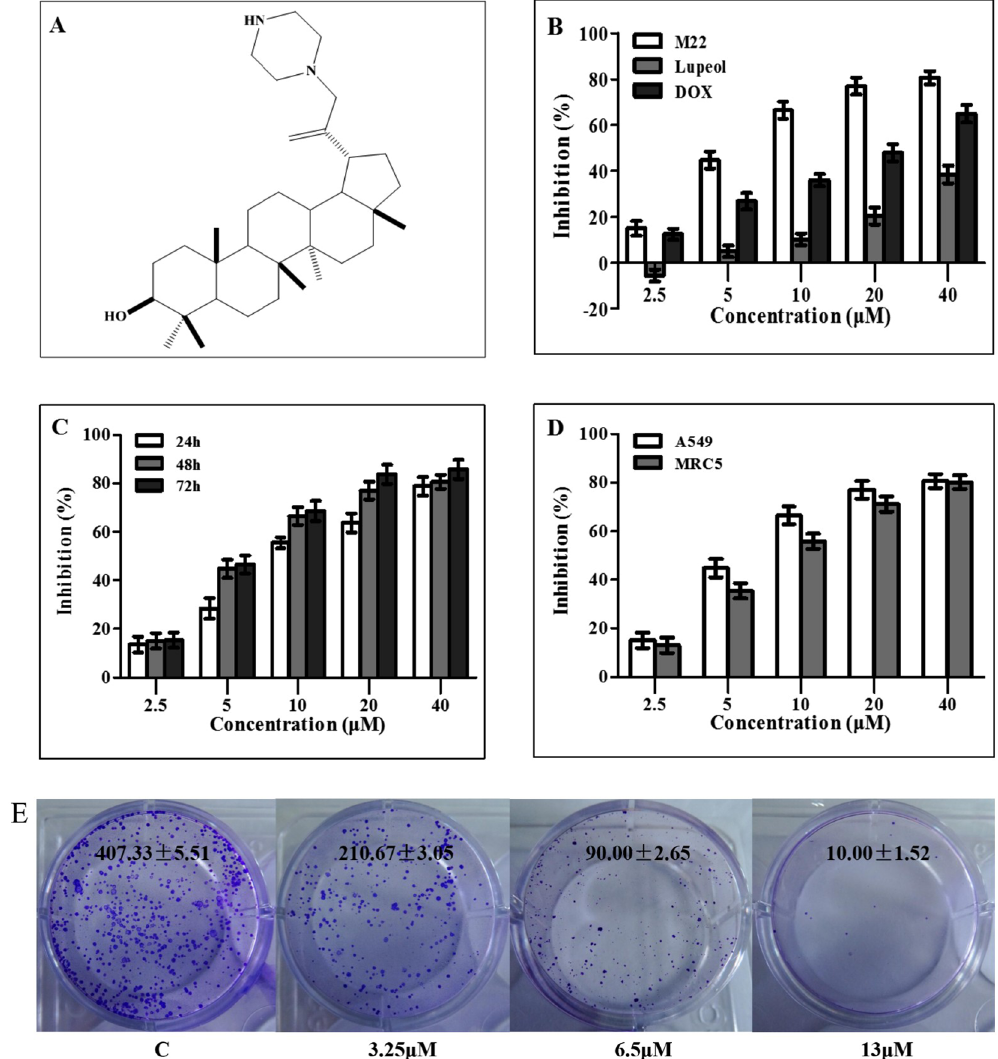
Figure 1. Chemical structure and cytotoxicity of M22. ( A ) Chemical structure of compound M22. ( B – C ) Dose- and time-dependent effect of M22 on inhibition of A549 cells. Cell viability was analyzed by MTT assay. ( D ) A549 and MRC5 cells were cultured with various concentrations of M22 for 48 h and cell inhibition was analyzed by MTT assay. The experiment was repeated three times and the data are presented as mean ± S.D. ( E ) Colony forming ability of A549 cells was inhibited by M22 (3.25 μ M, 6.5 μ M and 13 μ M) treatment for 10 days.